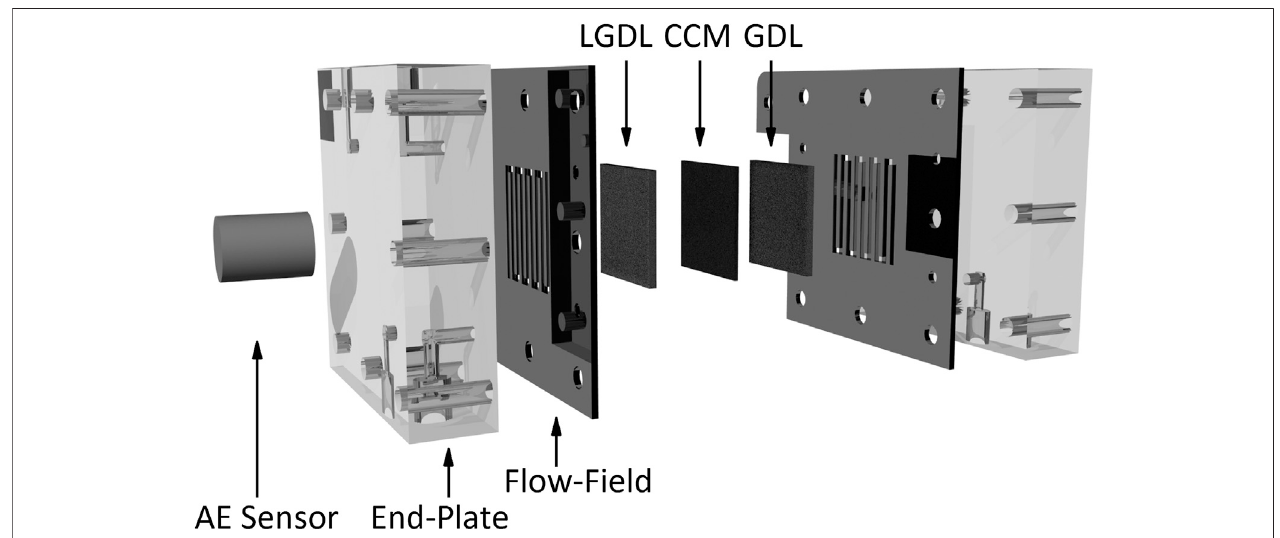
FIGURE 1 | Assembly of a polymer electrolyte membrane water electrolyser with the acoustic emission (AE) sensor, two end-plates, two fl ow- fi elds, the liquid-gas diffusion layer (LGDL), the catalyst coated membrane (CCM), and the gas diffusion layer (GDL) on the anode side.